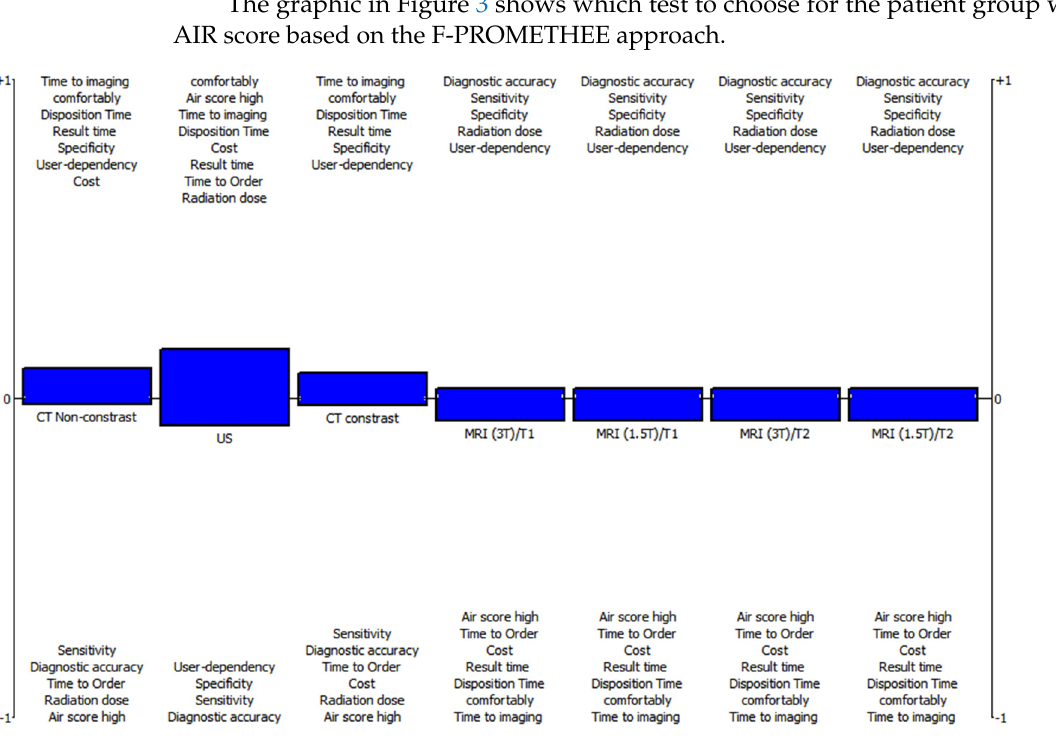
Figure 3. Evaluation of the acute appendicitis diagnosis for high AIR score patients with F-PROME- THEE.